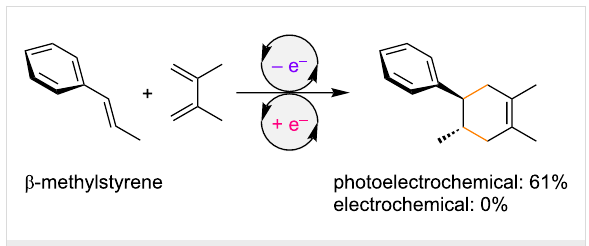
Scheme 1: Radical cation Diels–Alder reaction of β